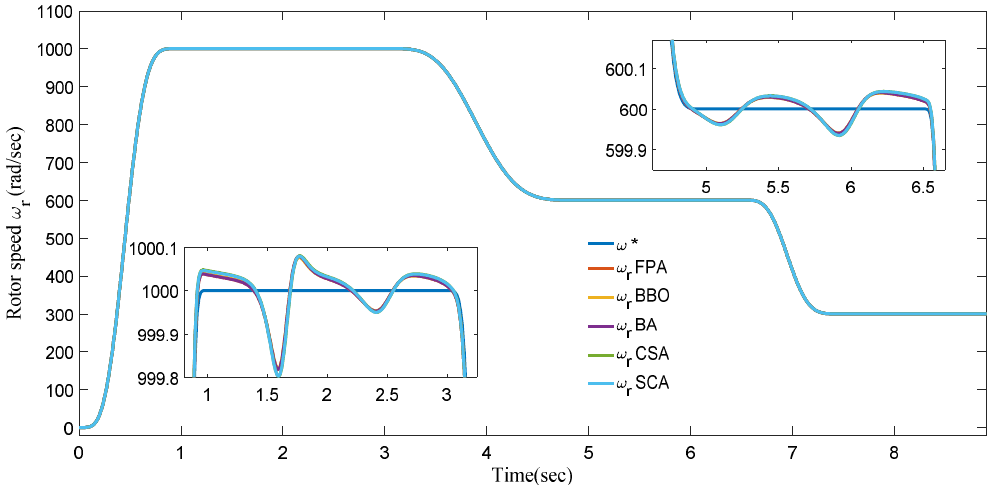
Figure 8. Simulated waveforms of the rotor speed responses, Case 1.